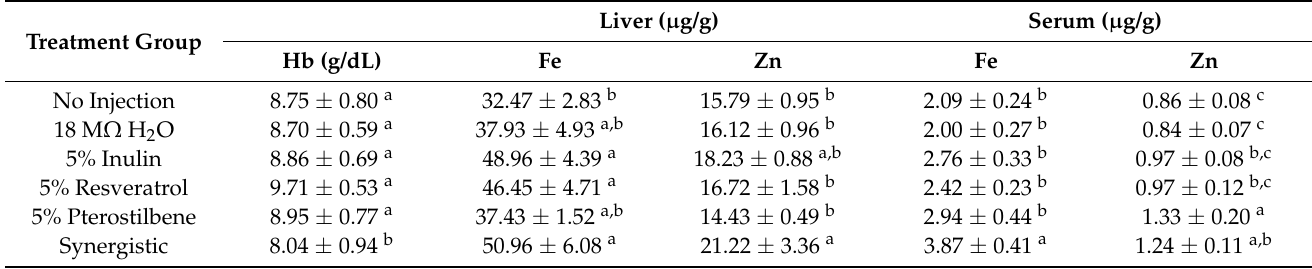
Table 3. Blood hemoglobin (Hb) concentration and Fe and Zn